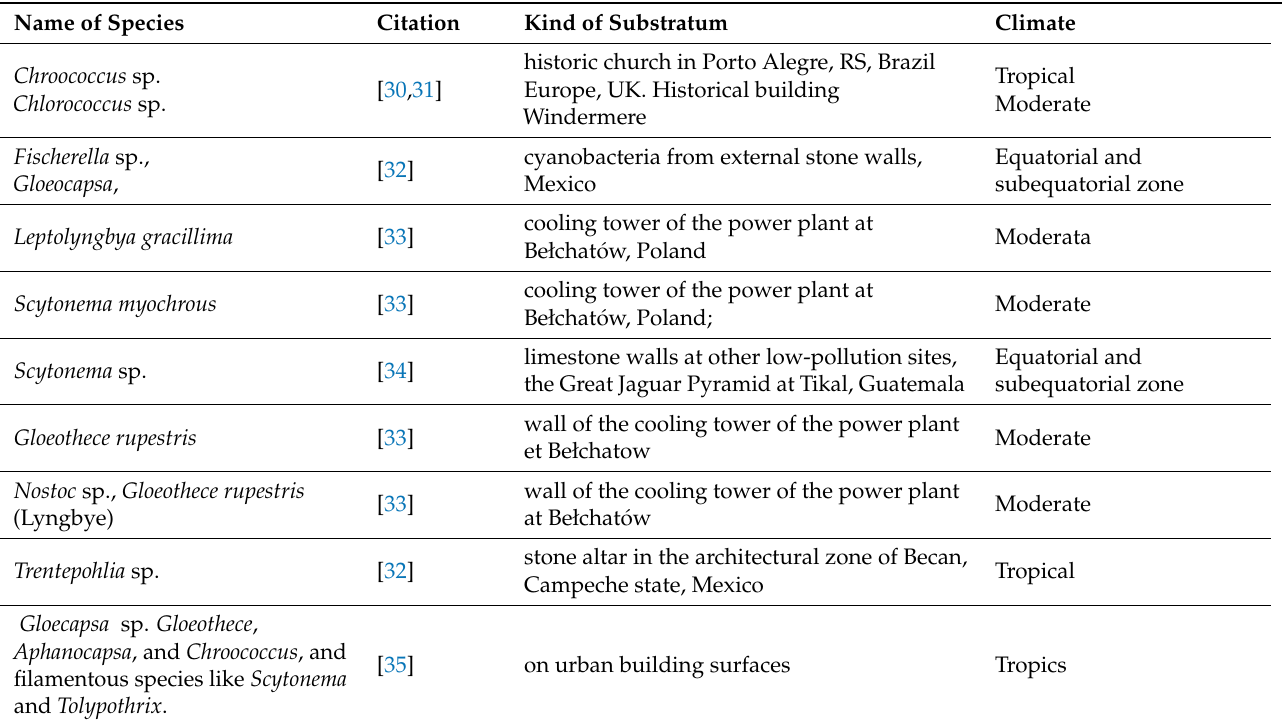
Table 1. The most frequent strains of Cyanobacteria identified in diverse architectural